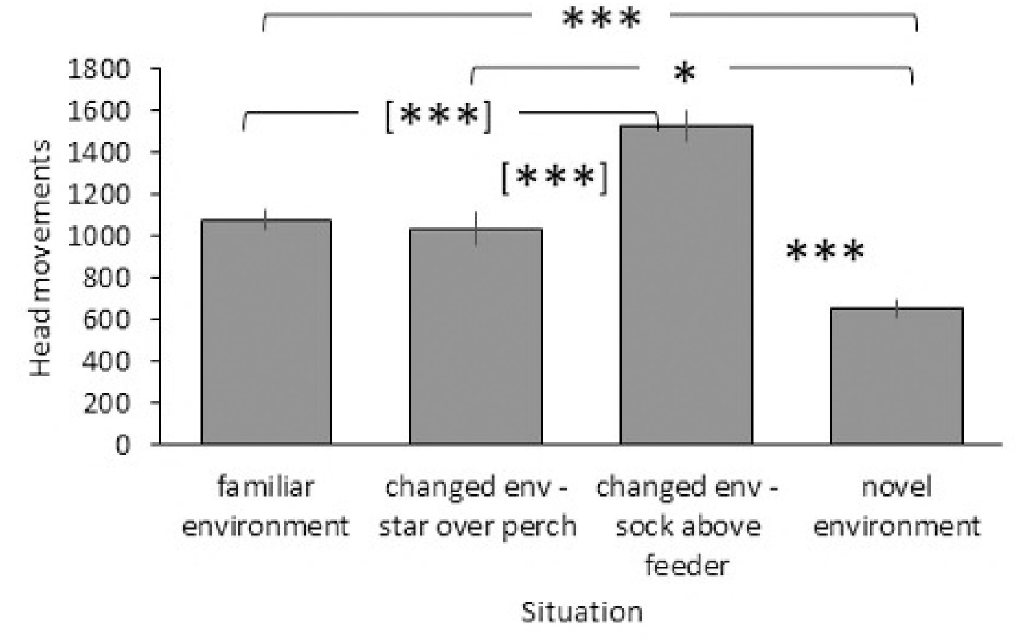
Fig 1. Plasticity in vigilance across situations. Mean and standard error of frequency of head movements per hour (n = 22) in four situations: familiar environment, two changed environments (star over neutral perch, sock above feeder) and novel environment. � P < 0.05; ��� P < 0.001; [ ��� ] P < 0.001 from additional paired t-tests.